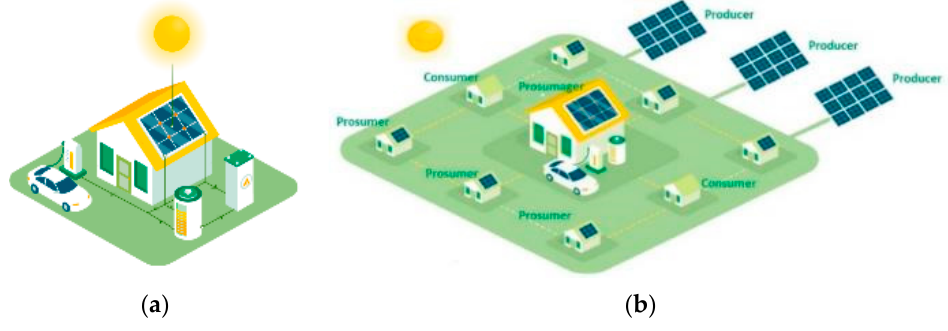
Figure 1. ( a ) A prosumager, ( b ) a renewable energy community.